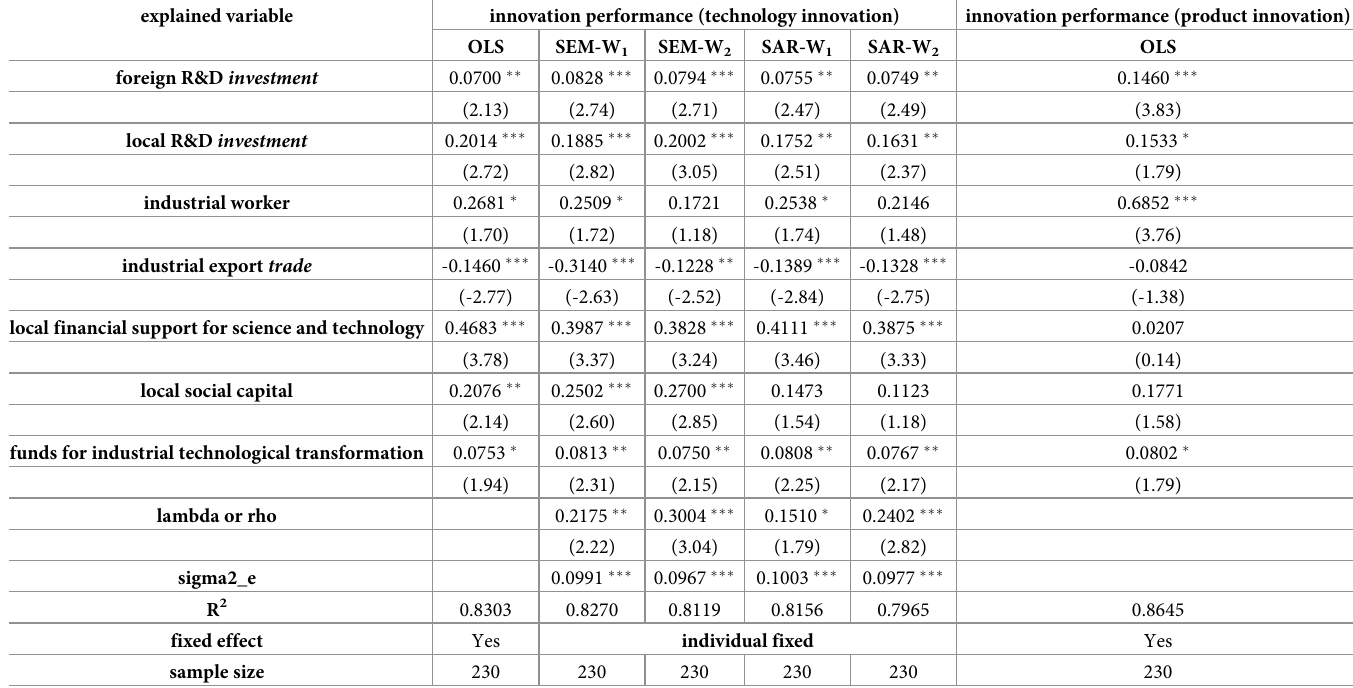
Table 5. Influence and spatial effect of foreign R&D on IP of HTI. explained